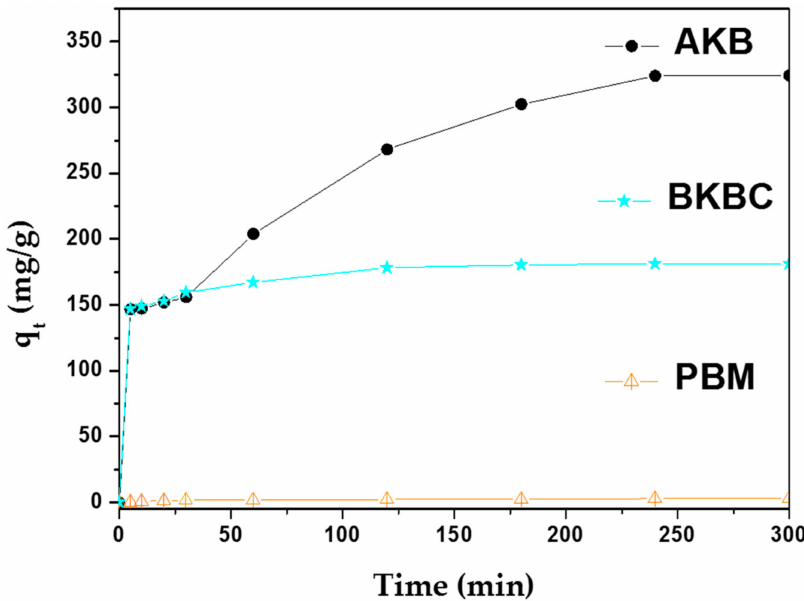
Figure 6. Effect of contact time on methylene blue (MB) adsorption by AKB, BKBC, and